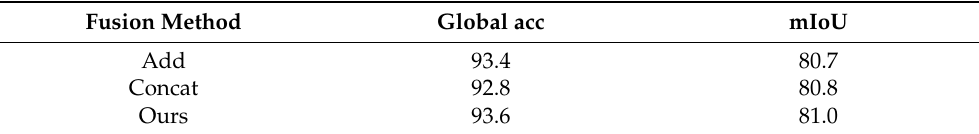
Table 1. The results in the experiment of fusion mechanism.